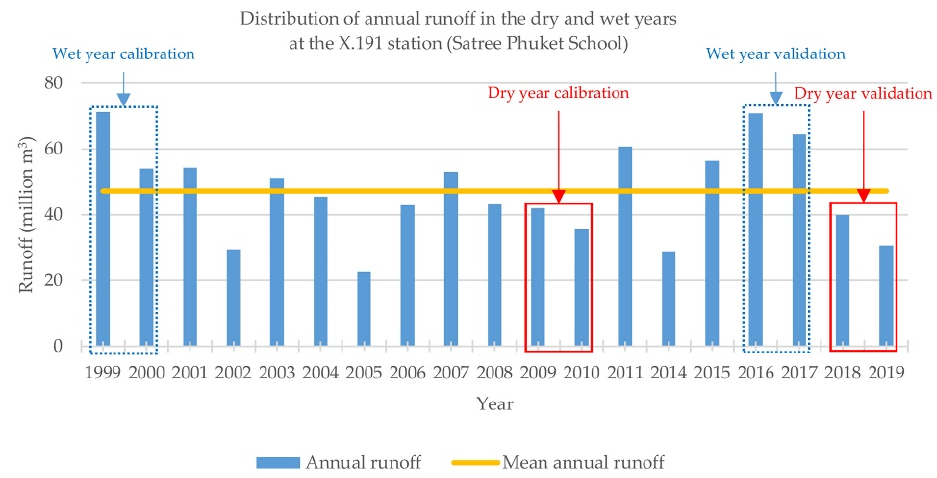
Figure 3. Distribution of annual runoff in the dry and wet year conditions at the X.191 station. Table 2. Essential data required for model calibration and validation under dry and wet year conditions. Required Data